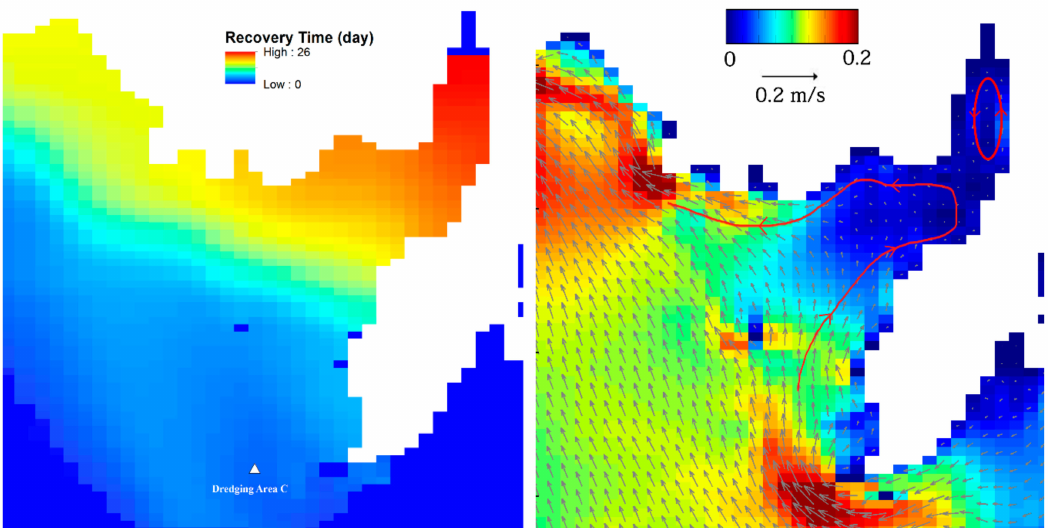
Figure 13. The recovery time to normal status and corresponding velocity field in the Huamiao lakelet, southeastern Poyang